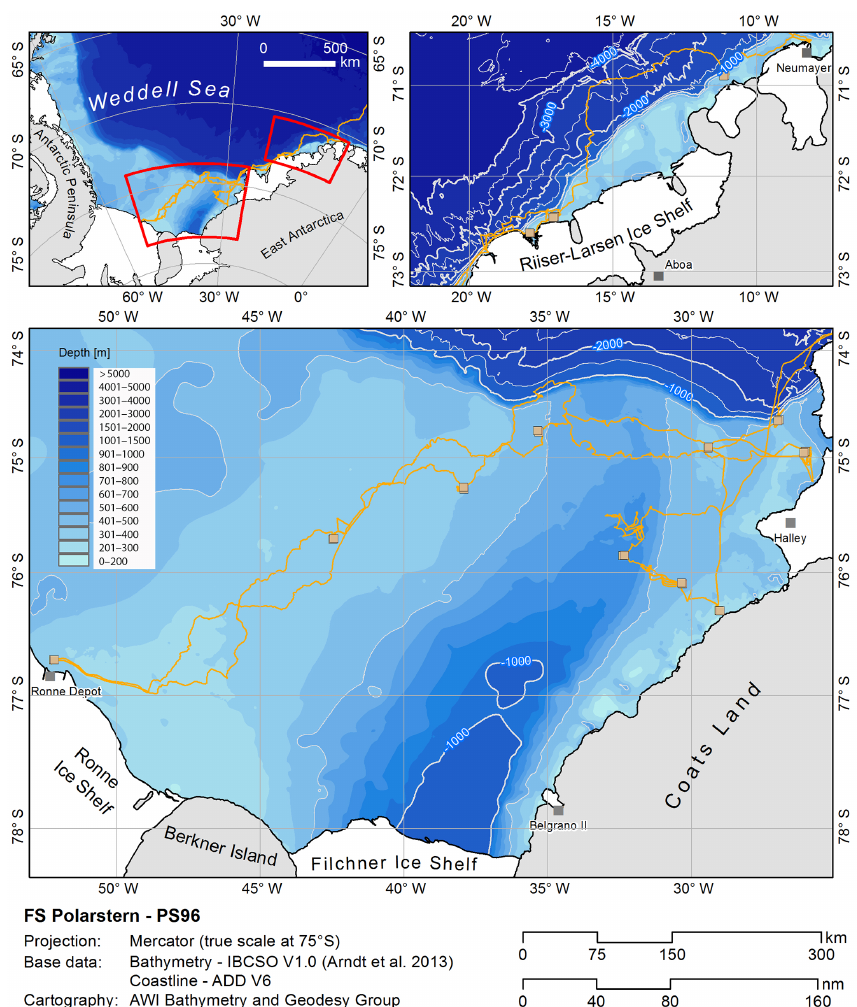
Figure 4. Maps showing the geographic positions of OFOS stations in the Weddell Sea during Polarstern cruise ANT-XXXI/2 (PS96) from December 2015 to February 2016 (after Schröder, 2016). Bathymetric data from IBCSO (Arndt et al.,